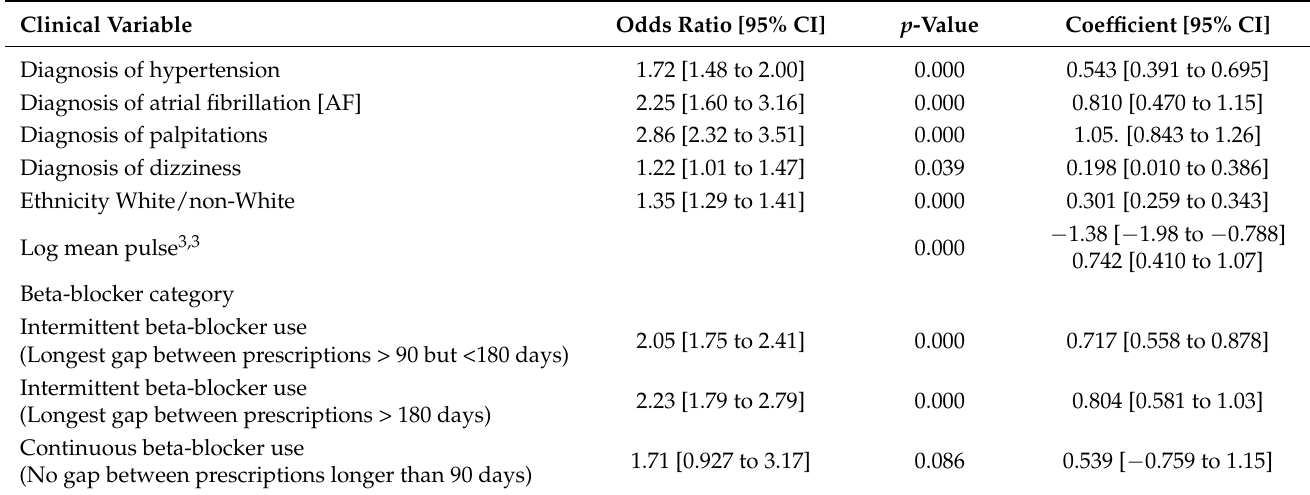
Table 3. Clinical features incorporated into final multivariable